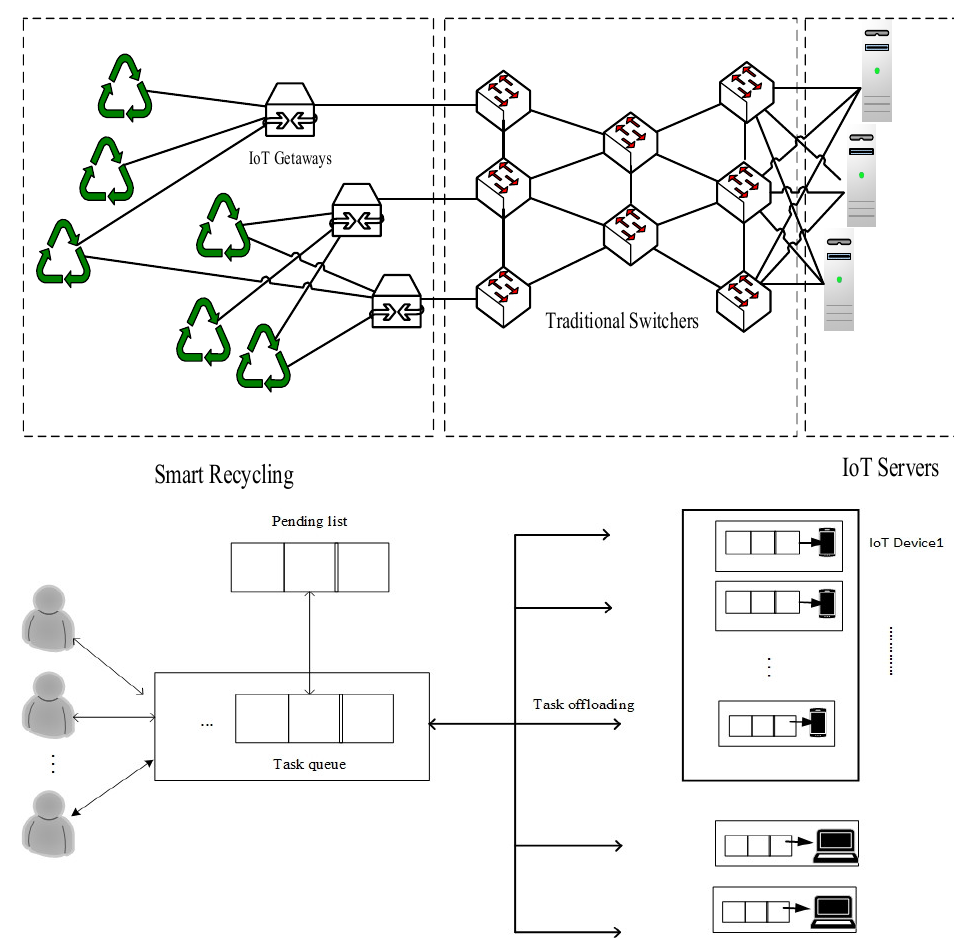
Figure 2. Task allocation in IoT.